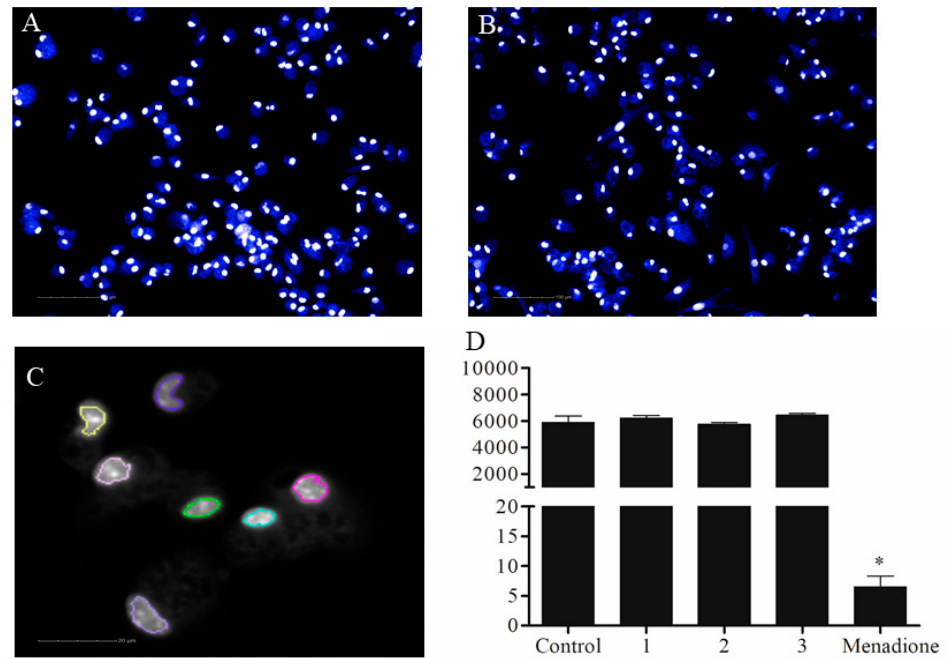
Figure 2. Automated drug toxicity assay. Macrophages from peritoneal exudate were collected from BALB/c mice. Cells were treated with compounds 1 – 3 at 50 μ M or with menadione at 50 μ M during 72 h. ( A ) Non-treated macrophages. ( B ) Macrophages treated with compound 2 at 50 µ M during 72 h. ( C ) Nuclei regions selected based on the “find nuclei” building block algorithmic from Harmony software. ( D ) Graph showing the nuclei number, the parameter used to quantify the number of cells after the treatment. The graph shows one experiment of two performed in quadruplicate. Bars are mean ± standard deviation (SD). * p < 0.05, one-way ANOVA analysis of variance related to